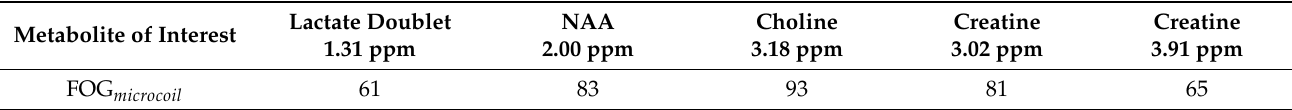
Table 2. FOG microcoil values averaged from five resonance